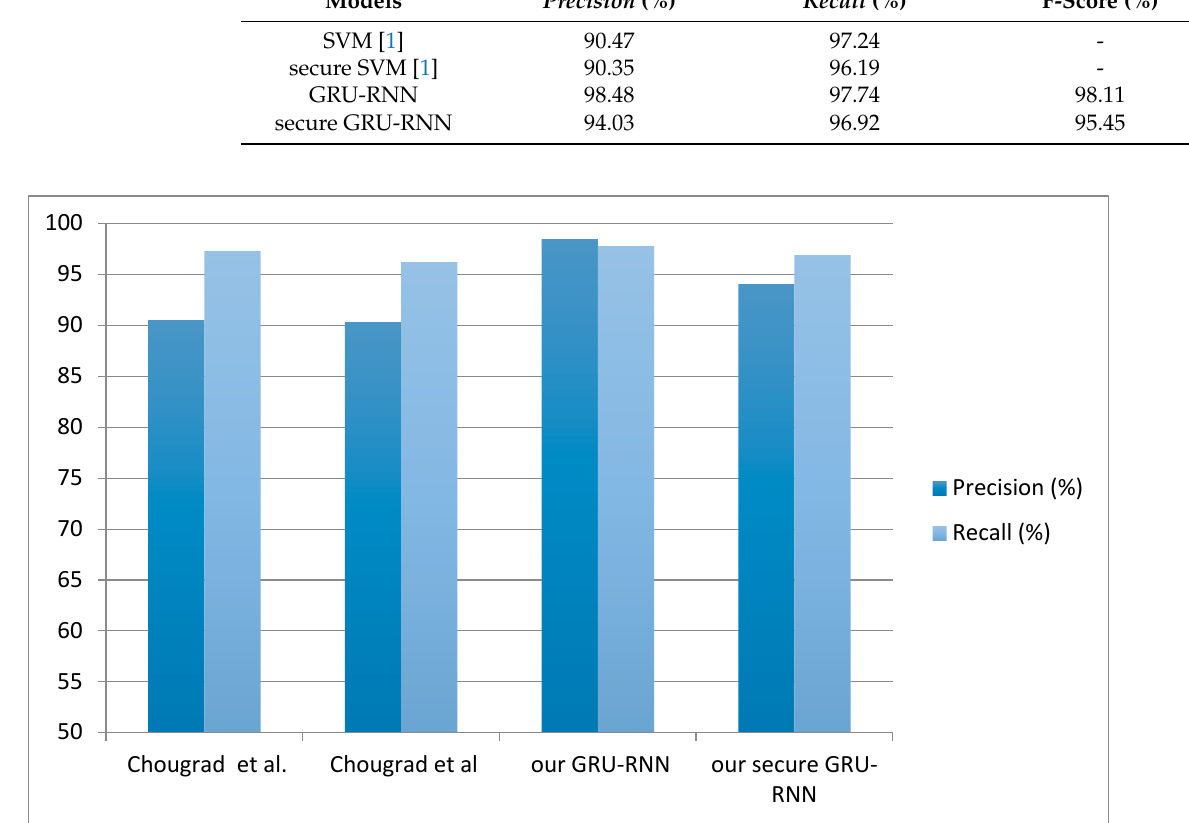
Figure 6. Performance comparison for the WDBC dataset.